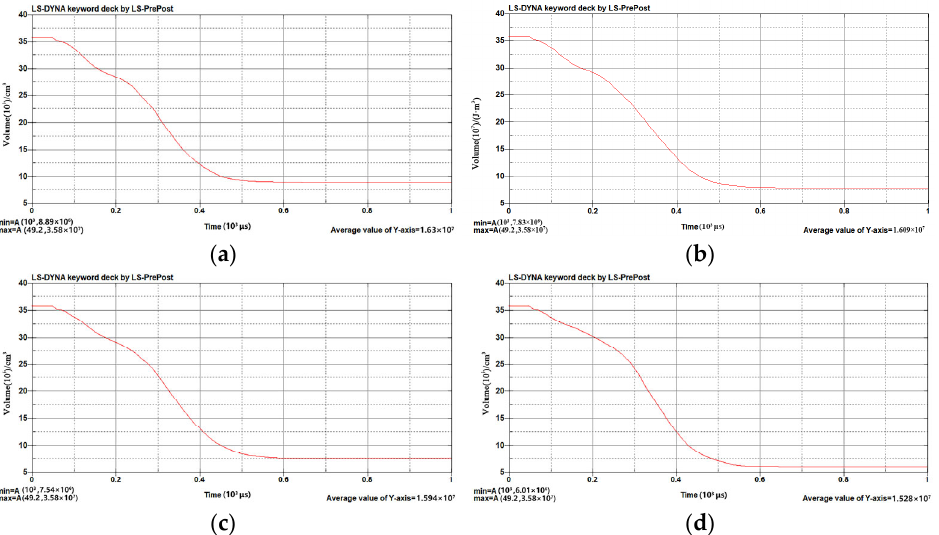
( d ) Figure 6. ( a ) Blasting with 3.2 kg TNT; ( b ) blasting with 4.8 kg TNT; ( c ) blasting with 6.4 kg TNT; ( d ) blasting with 8.0 kg TNT. From the figure, it can be seen that the maximum pressure of the equivalent pressure cloud was 6.89966 × 10 − 5 GPa when the explosive mass was 1.6 kg, the maximum pressure of the equivalent pressure cloud was 6.16525 × 10 − 5 GPa when the explosive mass was 3.2 kg, the maximum pressure of the equivalent pressure cloud was 7.77053 × 10 − 5 GPa when